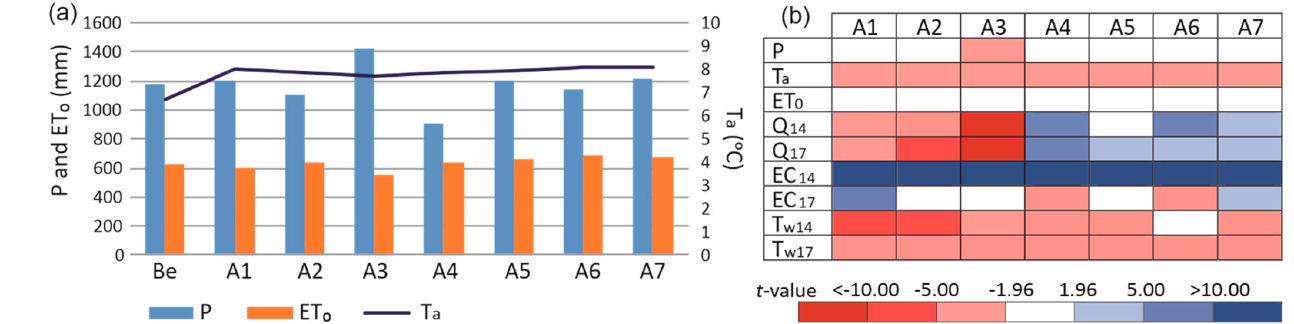
Figure 5. ( a ) Annual totals of precipitation (P), reference evapotranspiration (ET 0 ), and average annual air temperature (T a ) in the study area in the pre- (Be) and post-deforestation (A1–A7) periods. ( b ) Significant (colored) differences between the pre-deforestation period (Sep 2011–Aug 2013) and each year after deforestation (A1–A7) for P—precipitation, T a —air temperature, ET 0 —reference evapotranspiration, Q 14 and Q 17 —stream discharge at Wu14 and Wu17 measurement site, EC 14 and EC 17 —water electric conductivity at Wu14 and Wu17 measurement site, T w14 and T w17 —water temperature at Wu14 and Wu17 measurement site; average daily data for the whole period analyzed. Light, medium, and dark blue colors indicate small, medium, and large decreases, respectively ( t > 1.96), and light, medium, and dark red colors indicate small, medium, and large increases, respectively ( t < − 1.96).